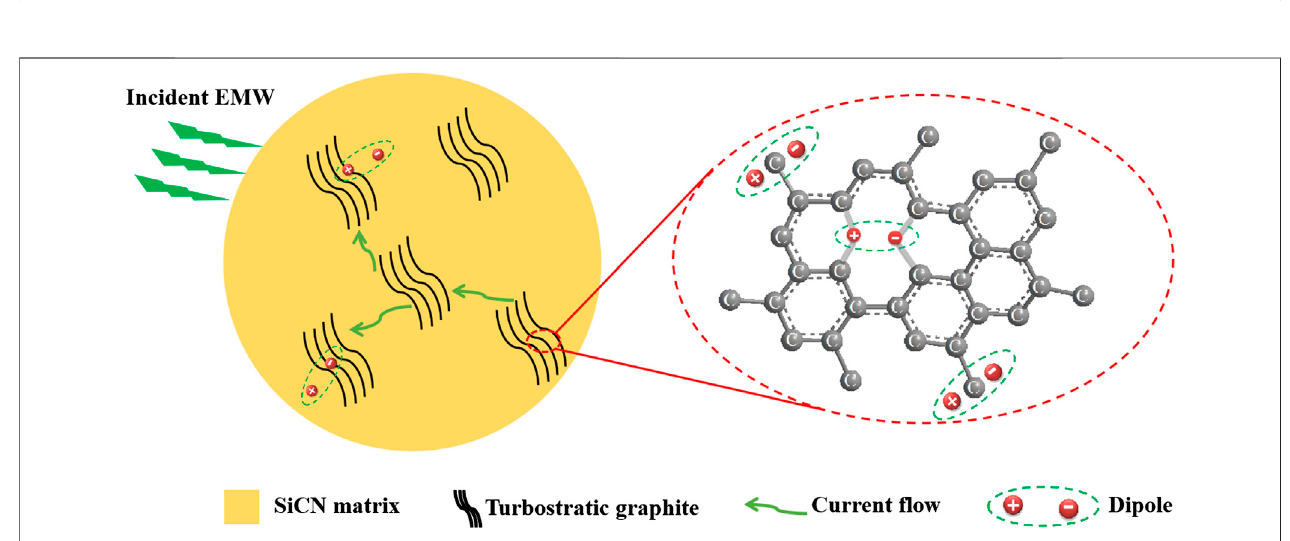
FIGURE 6 | Three-dimensional plots of the RL values vs frequency and thickness: SCN-1,300 (A) , SCN-1,400 (B) , SCN-1,500 (C) , and SCN-1,600 (D) .